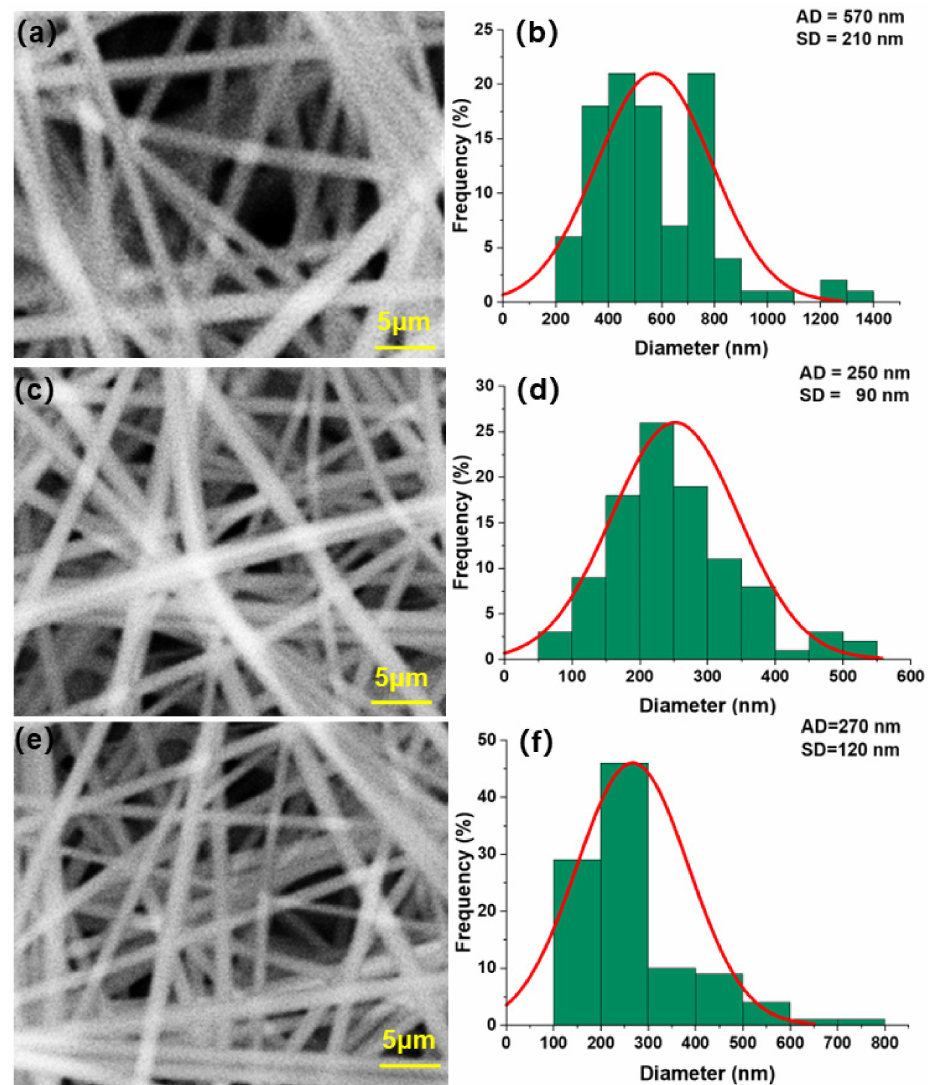
Figure 4. SEM morphology and fiber diameter frequency distribution of nanofiber membrane electrospun by PUL solution at different concentrations. ( a ), ( c ) and ( e ) are SEM images of nanofiber membranes prepared by PUL solution at 16%, 20% and 24%, respectively; ( b ), ( d ) and ( f ) are the fiber diameter frequency distributions of nanofiber membranes prepared by PUL solution at 16%, 20% and 24% concentrations,